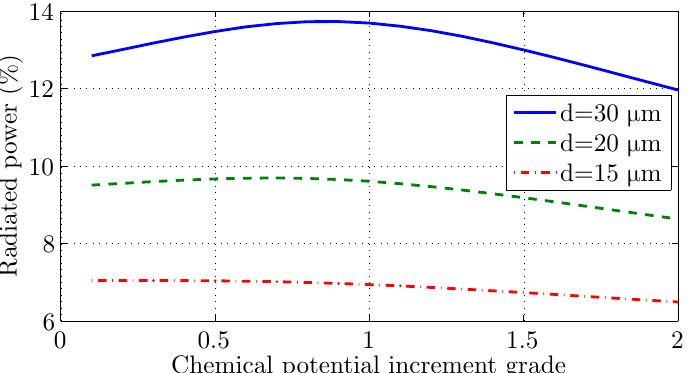
Figure 7. Surface wave power flow to free space for a graphene layer of µ c = 0.1eV with matching component termination of graded chemical potential